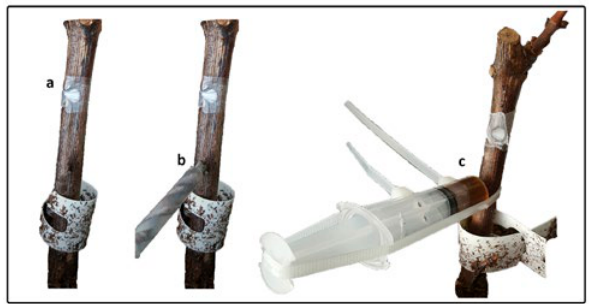
Figure 1. Schematic illustration of treated grapevine cut- tings. Pathogen inoculation, via mycelium plugs or conidia suspensions, occurred at point (a). For endotherapy, a drill hole (b) was made 3 cm below point (a) and a modified sy - ringe was placed in the hole (c) to force chemicals into the stem